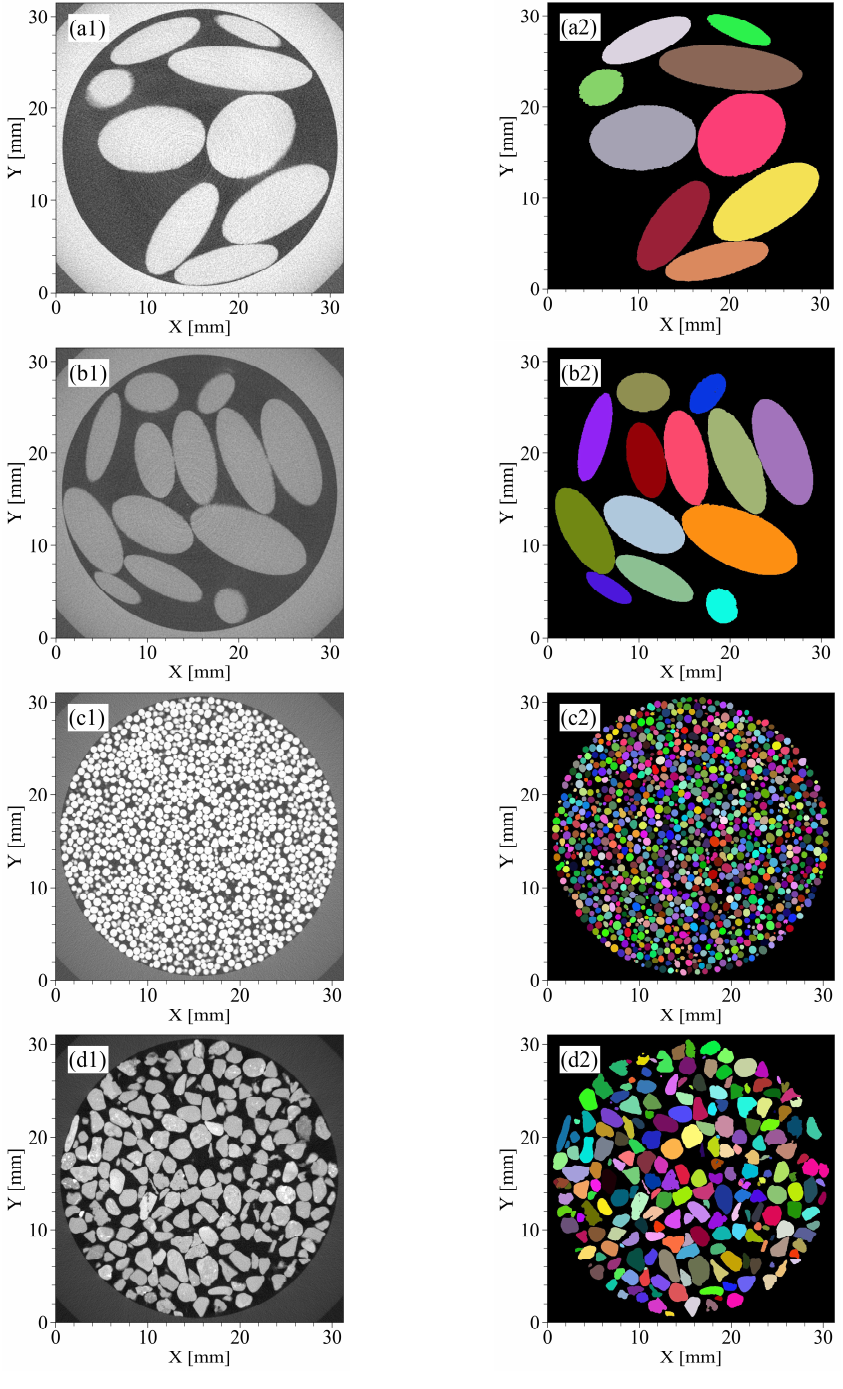
Figure 4. CT images and segmented images of four materials poured into acrylic glass columns: ( a1 , a2 ) RP1 and ( b1 , b2 ) RP2 (resin particles made by a 3D printer), ( c1 , c2 ) GBs (glass beads), and ( d1 , d2 ) KS (Kashima–Keisa natural sand). The left columns are CT images, and the right columns are segmented images.